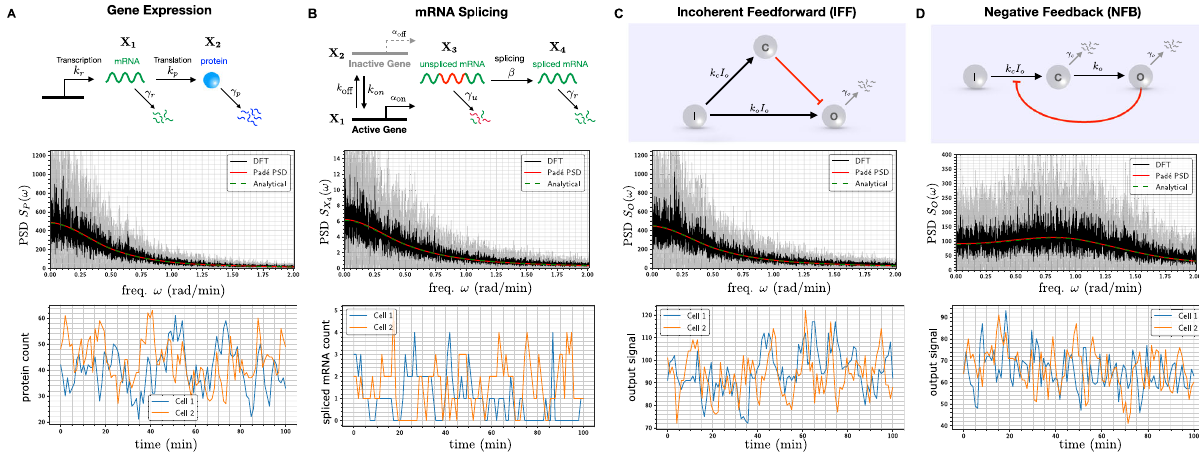
Fig. 2 Frequency-domain analysis of linear propensity networks. A This is the standard gene expression model where mRNA ( X 1 ) is transcribed constitutively and it translates into protein ( X 2 ). B In this RNA splicing network a gene can randomly switch between inactive ( X 2 ) (low transcription) and active ( X 1 ) (high transcription) states. When transcription occurs, unspliced mRNA ( X 3 ) is created which is then converted into spliced mRNA ( X 4 ) by the splicing machinery. C In the Incoherent Feedforward (IFF) network an input I (constant level I 0 ) directly produces the output O and it produces the controller species C , which represses the production of output O . D In the Negative Feedback (NFB) network the input I (constant level I 0 ) produces the controller species C , that produces the output species O which in turn inhibits the production of C from I . For all the networks single-cell output trajectories in the stationary phase are plotted. We provide a comparison of the single-cell PSDs estimated with three approaches — (1) analytically (see Table 1), (2) the Padé PSD method (see Table 1) using Q = 10 simulated trajectories and (3) the averaged periodogram or the DFT method mentioned in Box 1 using discrete samples from Q = 10 simulated trajectories. For the DFT estimator, the black curve represents the mean of the PSDs and the shaded grey region represents the symmetric one standard deviation interval around the mean. For the NFB network one can see that detecting the presence of oscillations in the fl uctuations is much easier in the frequency-domain than in the